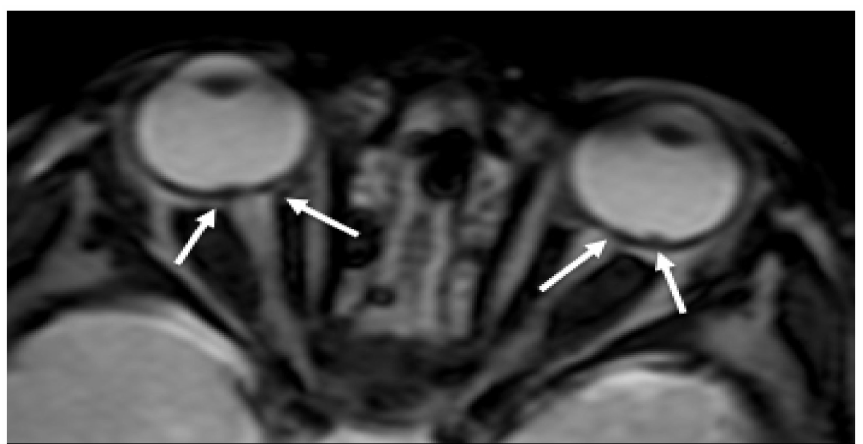
Figure 1. Axial GRE imaging shows irregular thickening and hypointensity of bilateral posterior ocular globes, indicative of retinal hemorrhage (arrows).